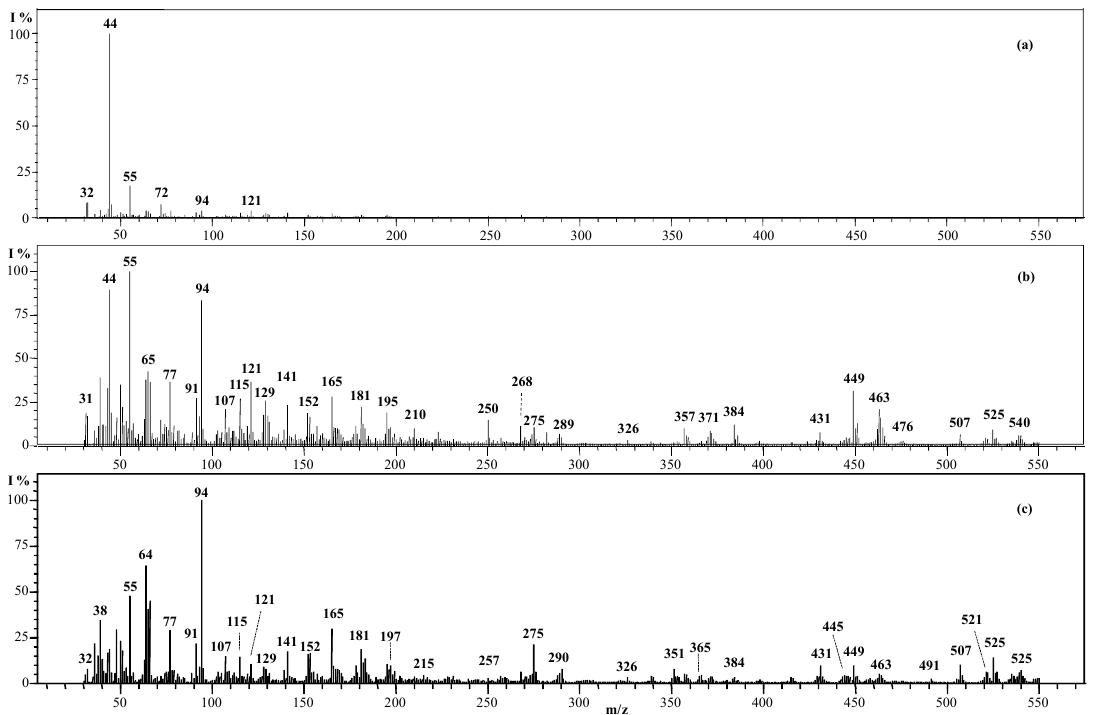
Figure 6. EI-DPMS mass spectra of the P(ESDPA) polymer recorded in the temperature ranges ( a ) ◦ C, ( b ) 430–480 ◦ C and ( c ) 480–500 ◦ 380–430 °C, ( b ) 430–480 °C and ( c ) 480–500 °C. ( a ) 380–430